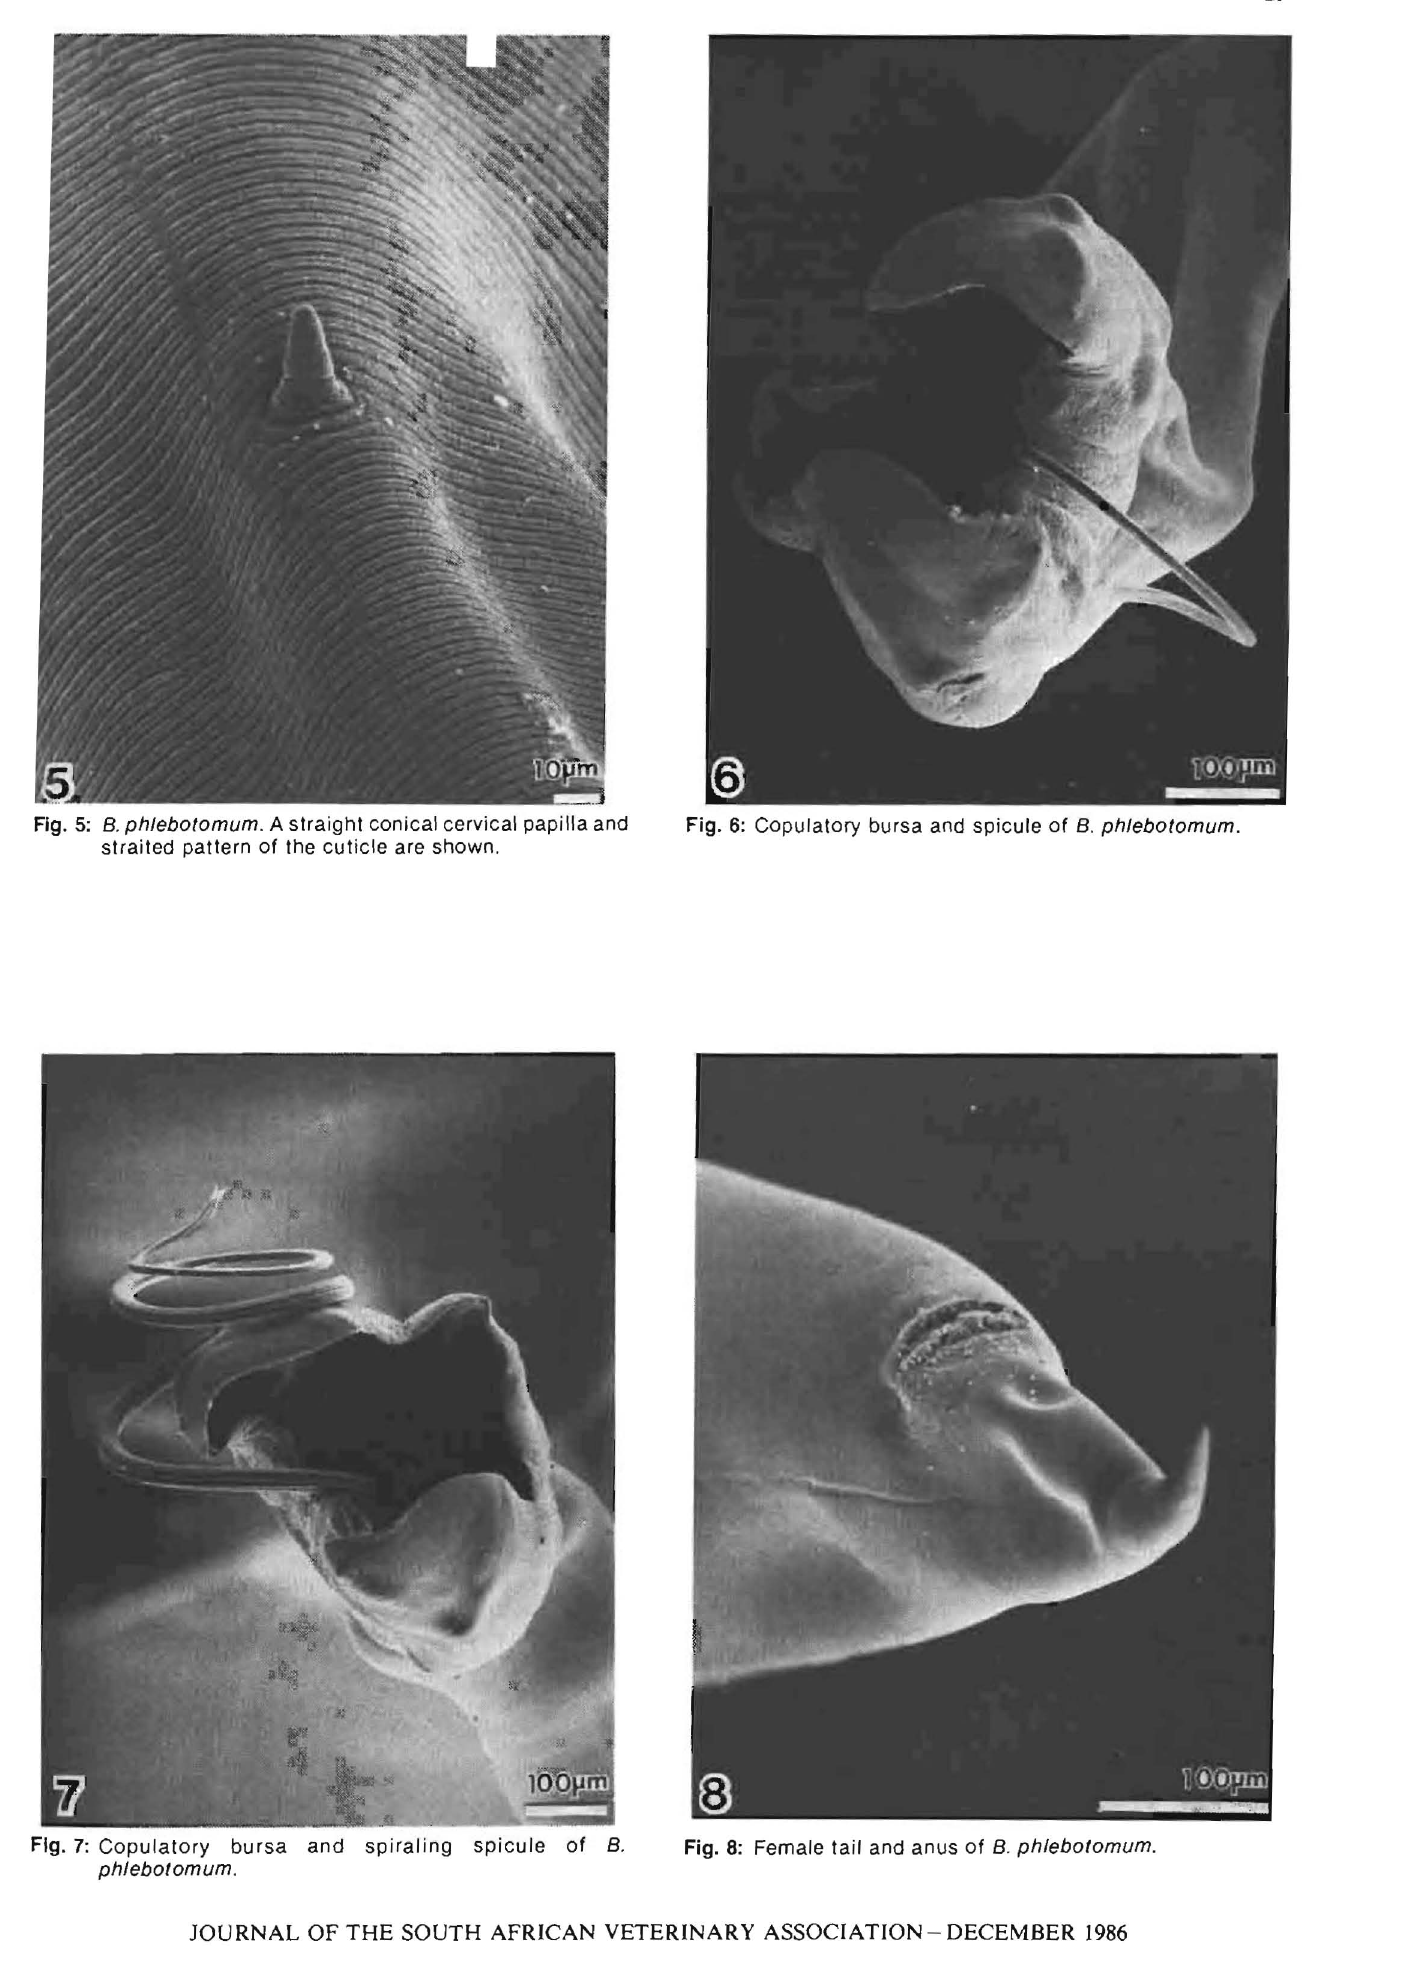
Fig. 8: Female tail and anus of B.